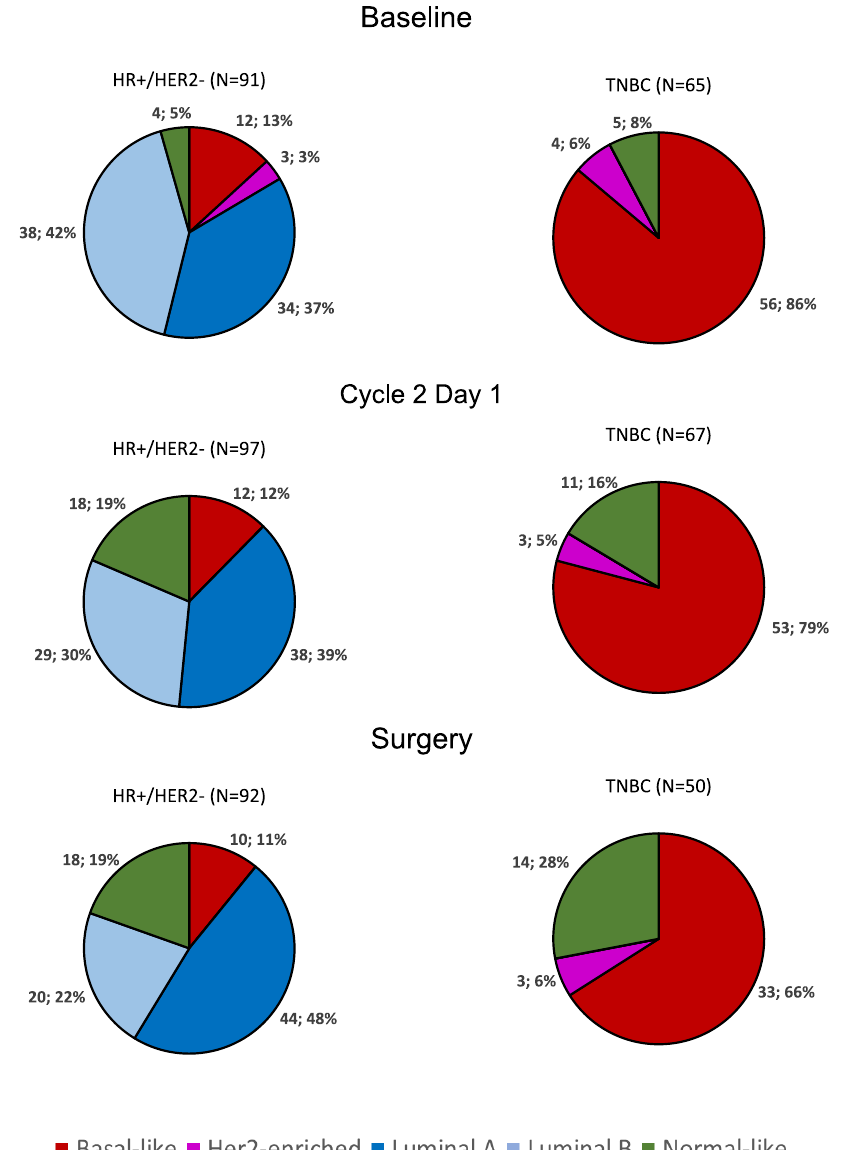
Fig. 4 Intrinsic subtype distribution in according to hormonal receptor status at Baseline, C2D1 and surgery. HR: hormone receptor; TNBC triple-negative breast